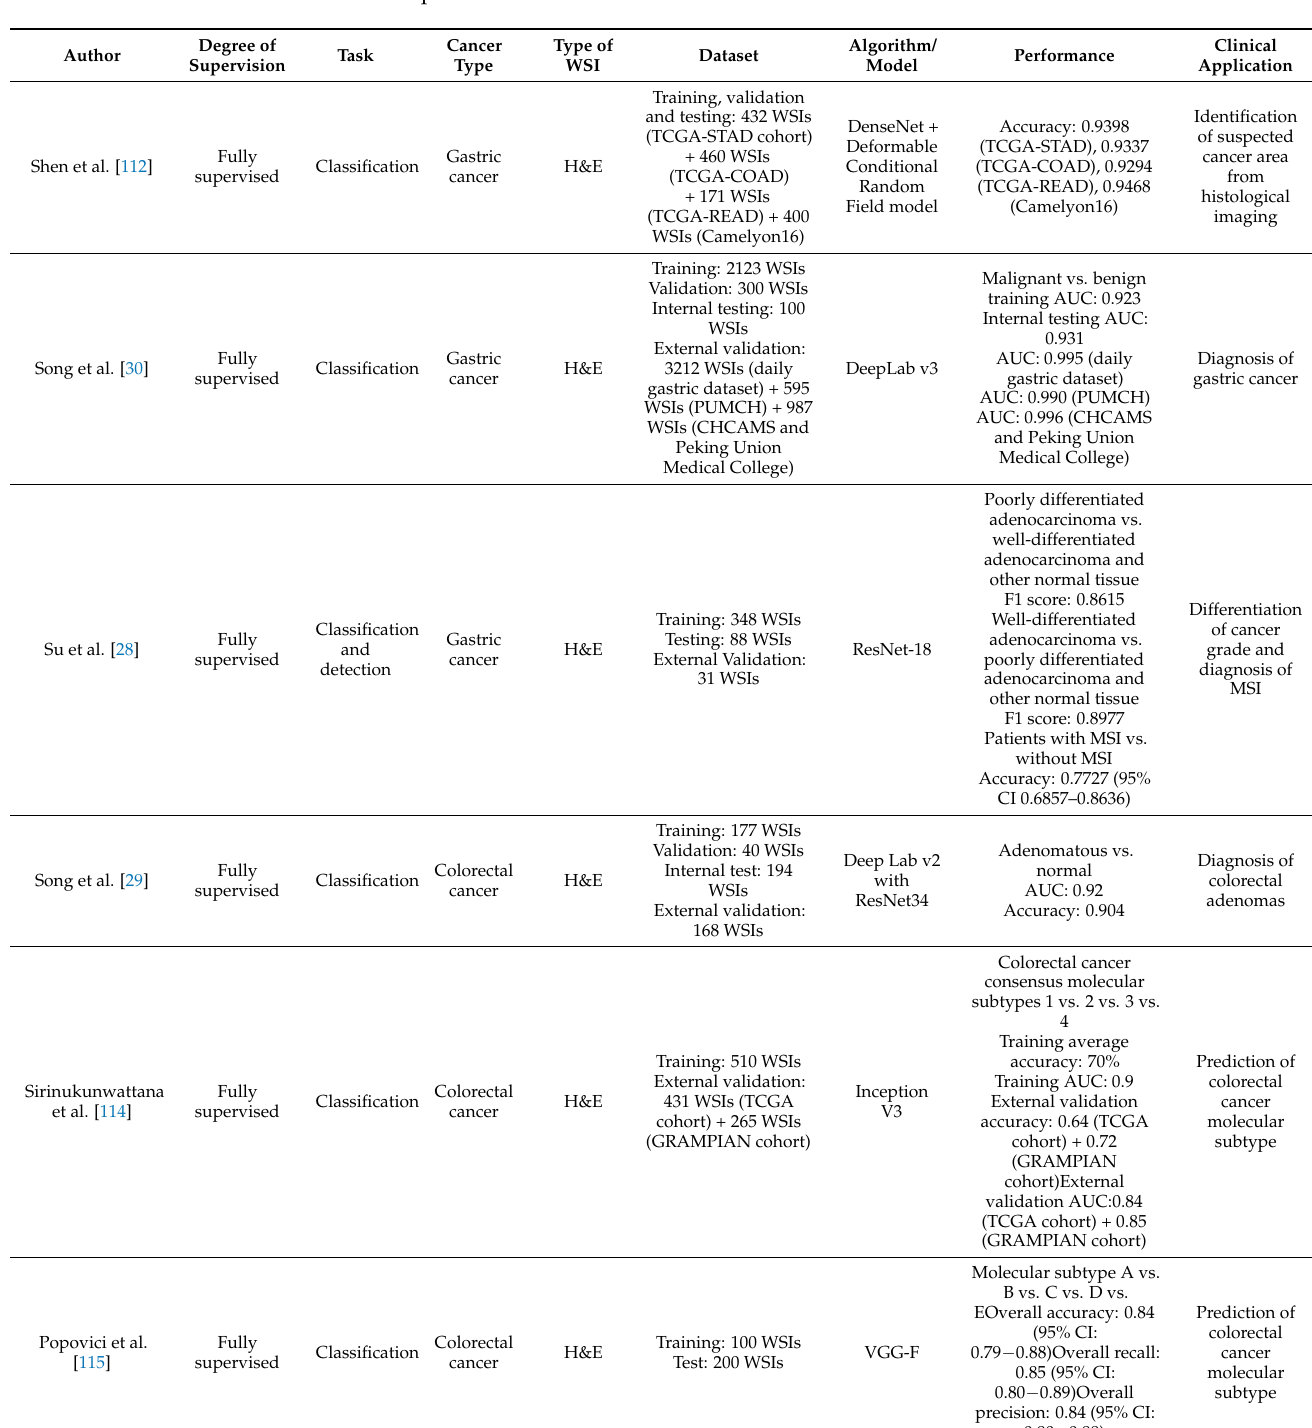
Table 2. Histopathologically related deep learning models used for clinical applications in GI cancers. Deep learning algorithm and models are grouped according to their specific computational task and GI cancer type to compare their performance and clinical applications. The sources of the datasets and sample sizes are also